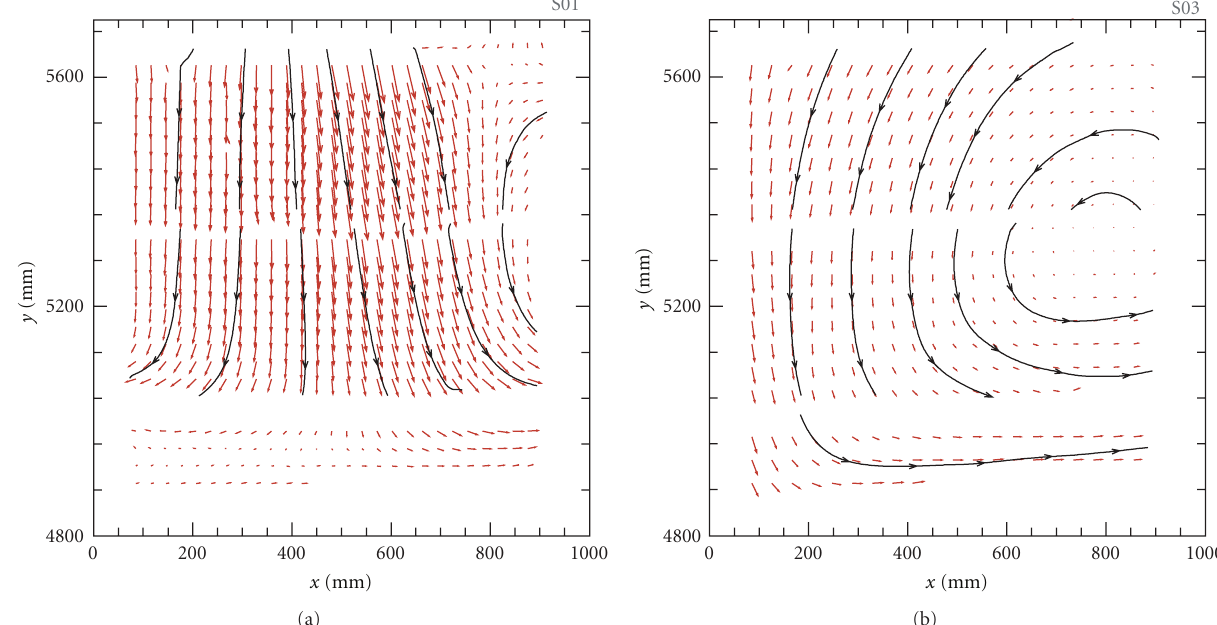
Figure 26: Selected mean velocity fields at position B for ST4 4 for (a) 1254 s < t < 1459 s and (b) 6456 s < t < 6661